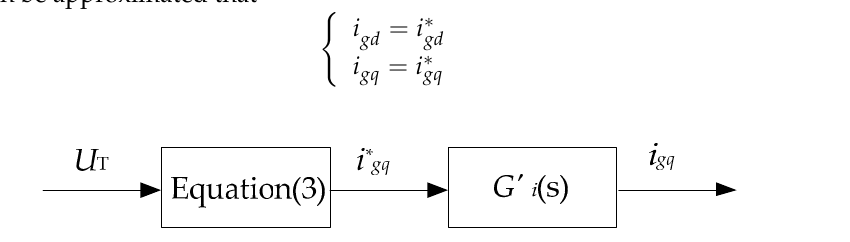
Figure 4. Control block diagram of inverter of the external q -axis voltage external loop.